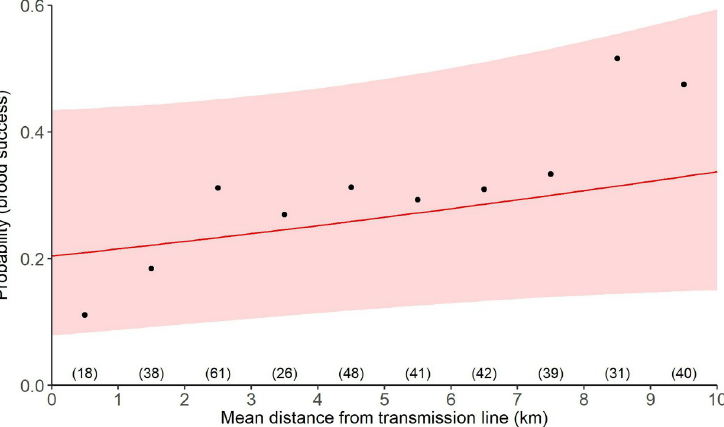
Fig 6. Effect of power lines on the greater sage-grouse ( Centrocercus urophasianus ; sage-grouse) in Utah, portions of southeastern Idaho, and southwestern Wyoming, USA, 1998–2013. Lines are population-averaged fitted values from the best-fit GLMM (S6 Appendix) describing the effects of transmission lines on sage-grouse brood success. Circles represent a binning of data points that informed the model; sample sizes within each 1 km bin are identified in parentheses. For example, 18 nests were recorded between 0–1 km from a transmission line, of which 11% (n = 2) persisted.